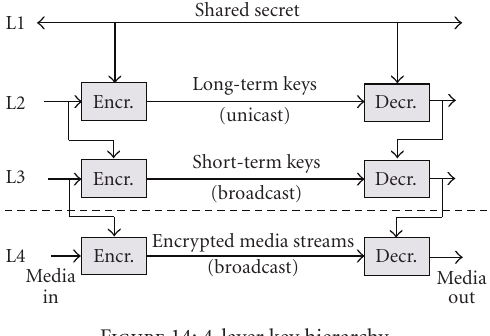
Figure 14: 4-layer key